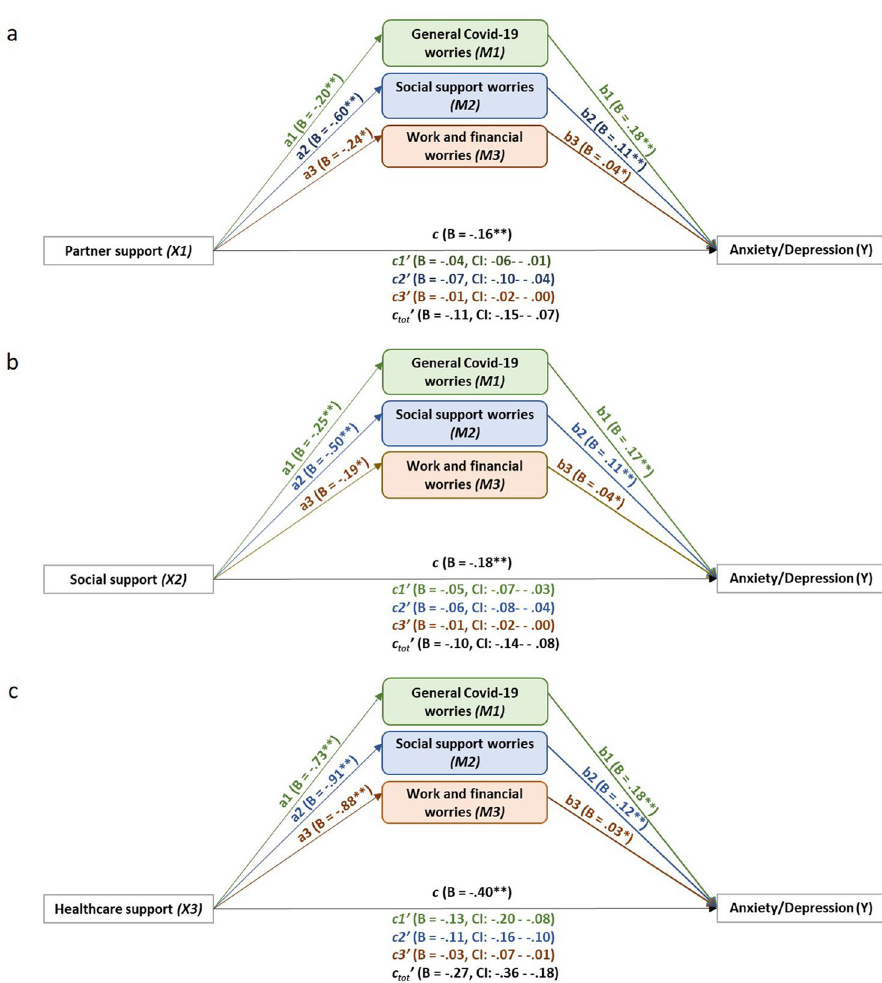
Figure 3. Illustration of the statistical mediation models of the total effect of ( a ) partner support, ( b ) social support and ( c ) healthcare support as IV (X1,2,3) on psychological distress (Y) through the c-path, mediated by general COVID-19 worries (M1, green), social support worries (M2, blue) and work and financial worries (M3, orange), indirect effect shown in c’-paths. The direct effects of the IV on the mediators is shown on the a-paths, and the direct effect of the mediators on the DV is shown in the b-paths. B = unstandardized coefficient. Significance level was set at .05. * p < .05, ** p <